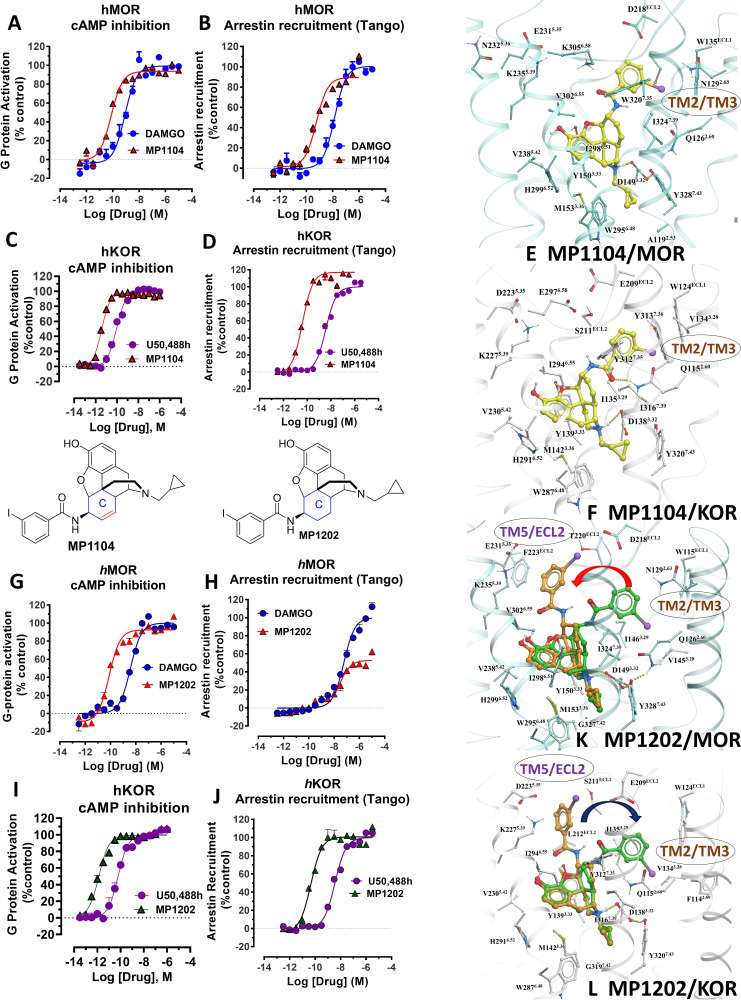
MP1104 at both MOR and KOR and MP1202 at KOR targets the TM2-TM3 region while MP1202 at MOR targets the TM5-ECL2 region and show distinct signaling properties.(A-B) MP1104 (red) is a full agonist in hMOR in cAMP inhibition (N = 5) and Tango-arrestin recruitment assays (N = 5) compared to DAMGO (blue). (C–D) MP1104 (red) is a full agonist in hKOR in cAMP inhibition (N = 3) and Tango-arrestin recruitment assays (N = 3) compared to U50,488H (purple). (E–F) The preferred docking pose of MP1104 (boat form, yellow stick) at MOR and MP1104 (boat form, yellow stick) in the active state of KOR. Ring-C of MP1104 in boat form forces the iodophenyl moiety to reside in a region between TM2-TM3 at MOR/KOR. (G–H) MP1202 (red) is a full agonist in hMOR in cAMP inhibition (N = 3) and partial agonist in Tango-arrestin recruitment assays (N = 3) compared to DAMGO (blue). (I–J) MP1202 (green) is a full agonist in hKOR in cAMP inhibition (N = 3) and in Tango-arrestin recruitment assays (N = 3) compared to U50,488h (purple). (K–L) The docking poses of MP1202 (chair form, brown stick) and (boat form, green stick) at an active states of MOR and KOR are shown. At MOR, the saturated ring C in MP1202 leads to interaction of the ligand in the ECL2 and TM5 region leading to a preference of chair form shown by a red arrow. At KOR, MP1202 behaves similar to MP1104 and the flip of ring C conformation from chair to boat is shown by a blue arrow. See Appendix 1—table 7 for values, Appendix 1—figure 4 and Appendix 1—table 10 for bias calculations.